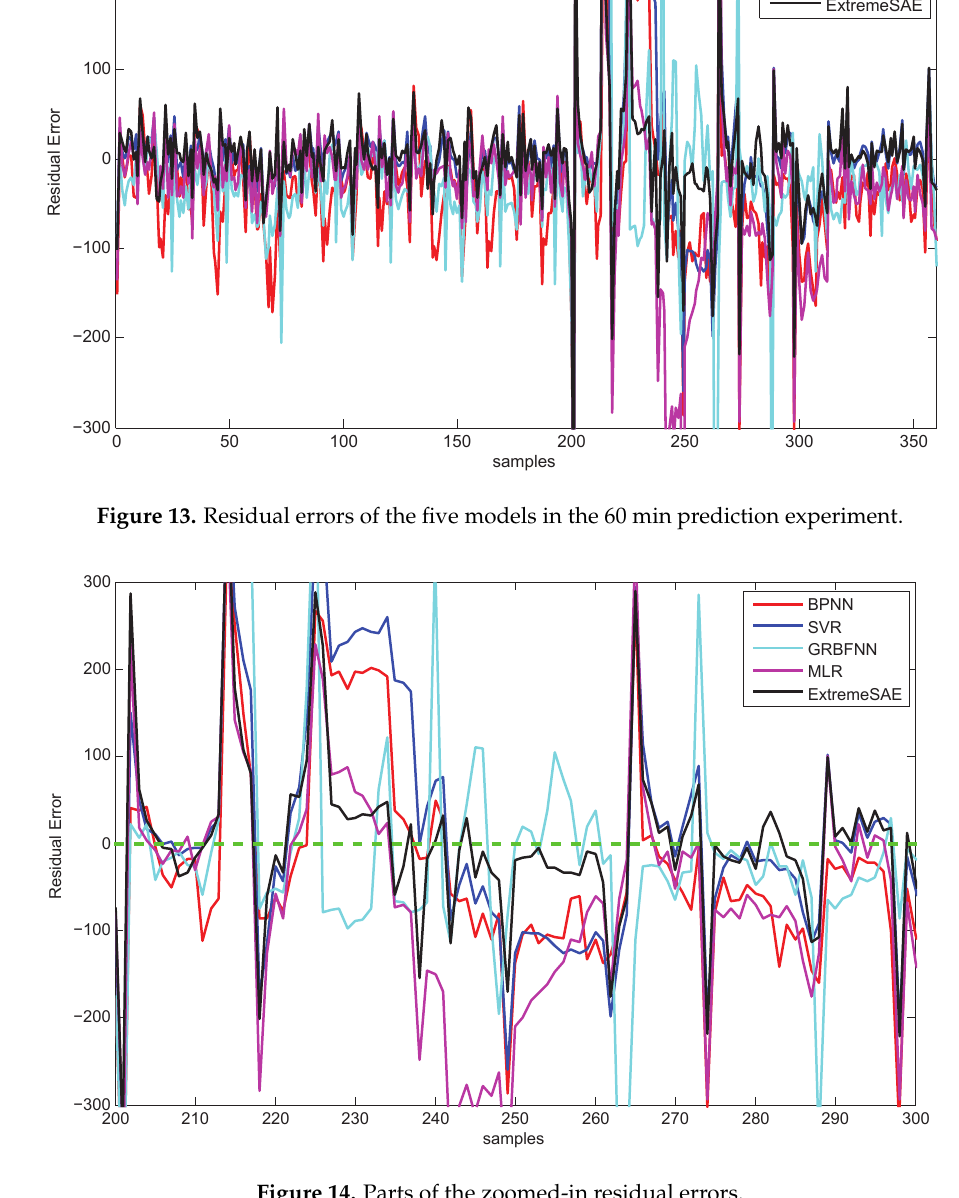
Figure 14. Parts of the zoomed-in residual